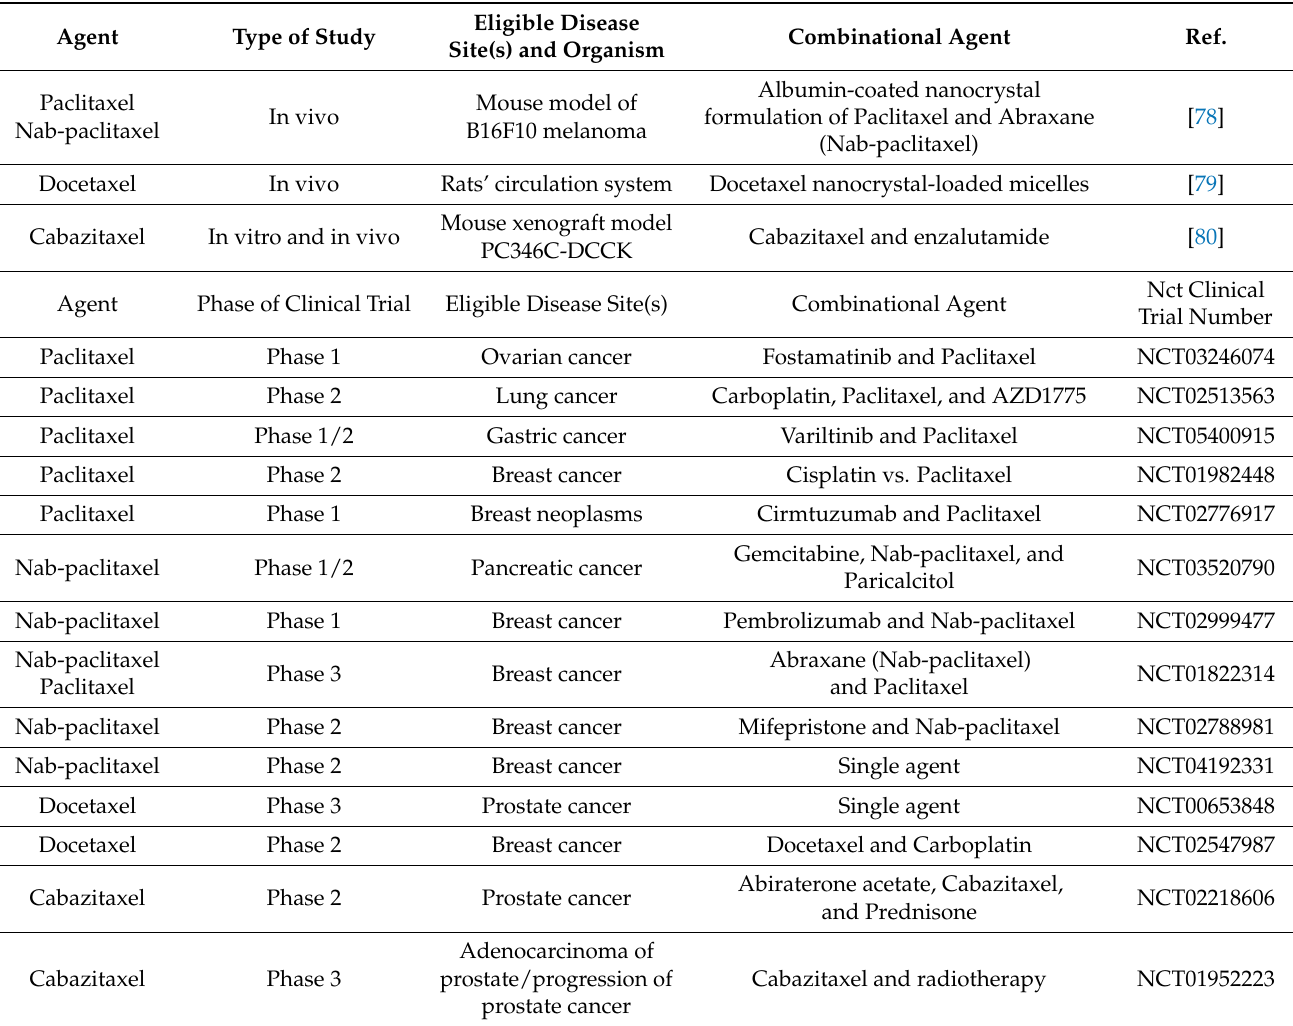
Table 1. Preclinical and clinical studies with paclitaxel and its derivatives in monotherapy and combination